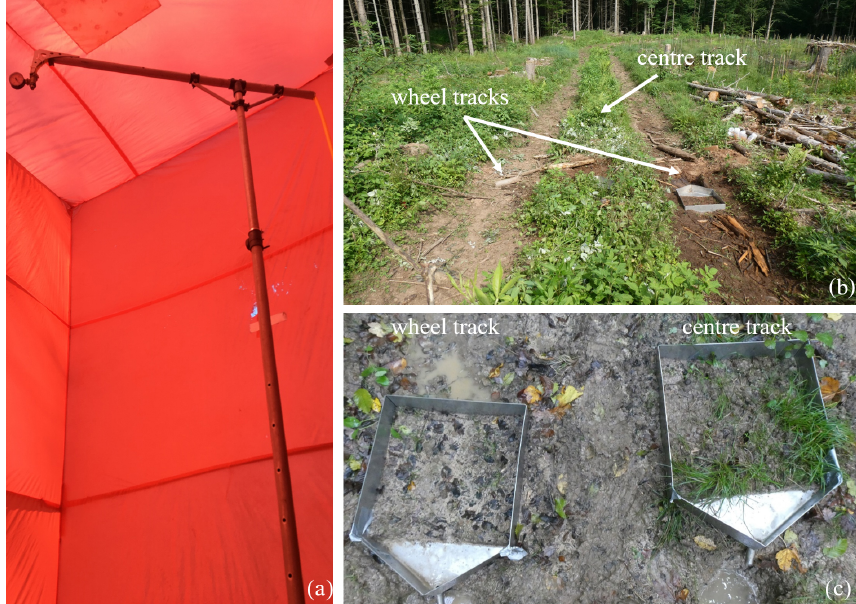
Figure A2. Experimental setup. (a) Tübingen rainfall simulator inside the protective tent. (b) Skid trail in the Trossingen Formation (TS) in July 2019. (c) Runoff plots in the wheel track and the centre track in the Angulatensandstein Formation (AS) in October